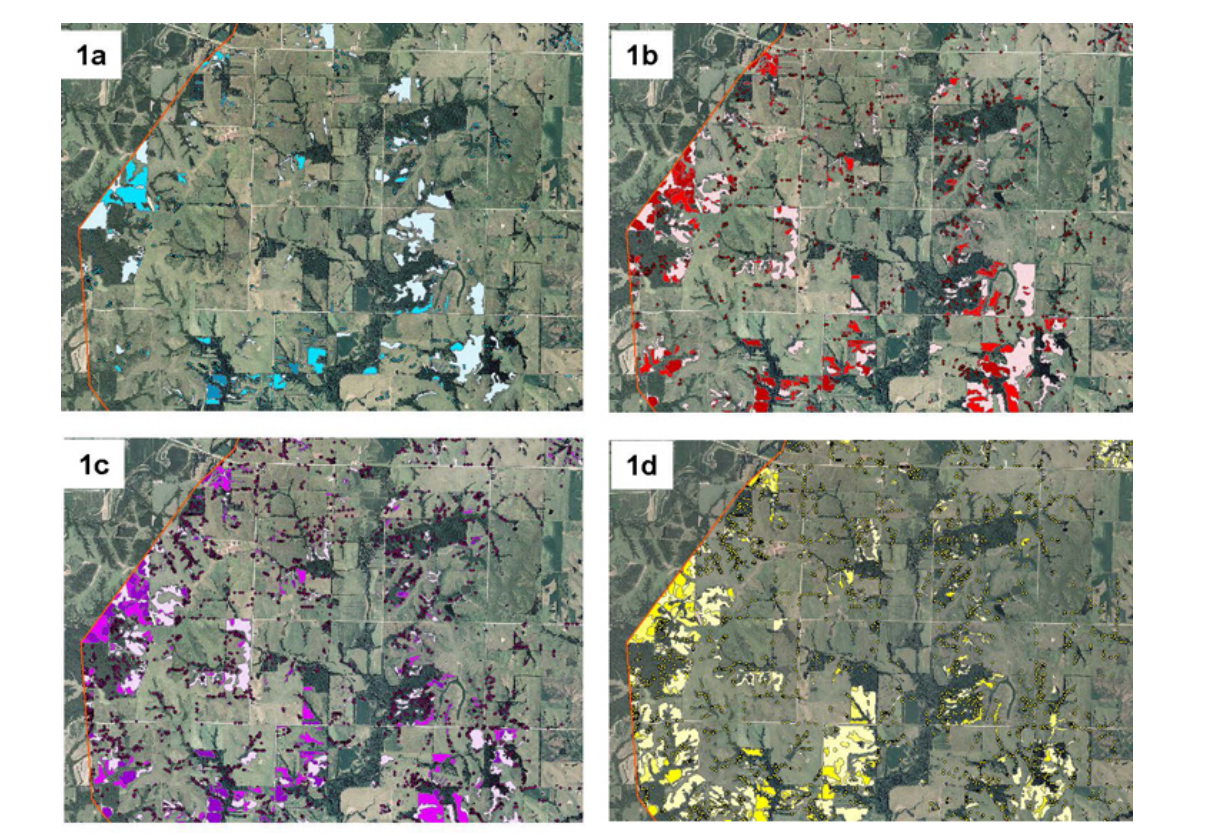
Fig. 1 . Encroachment of eastern redcedar in 1983 (1a), 1990 (1b), 2002 (1c), and 2009 (1d) in the central Grand River Grasslands. Points represent individual trees on the landscape; polygons represent stands of eastern redcedar, with darker shades representing progressively denser